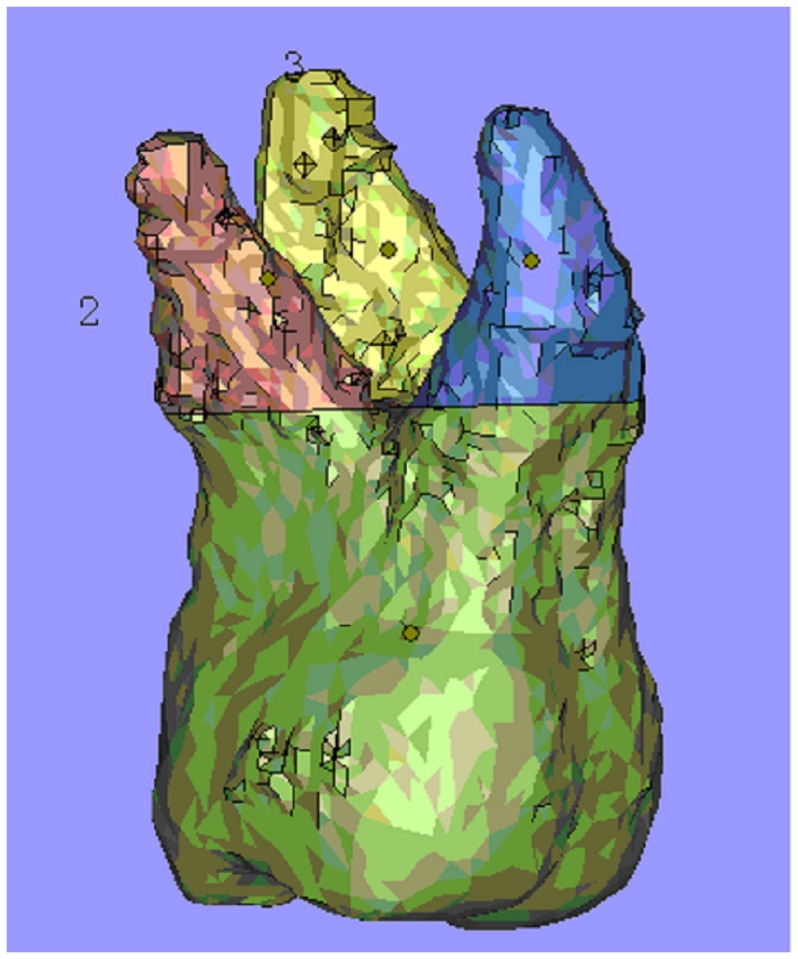
Isolation of the roots of first molar.1 is the mesiobuccal root; 2 is the distobuccal root; 3 is the palatal root.